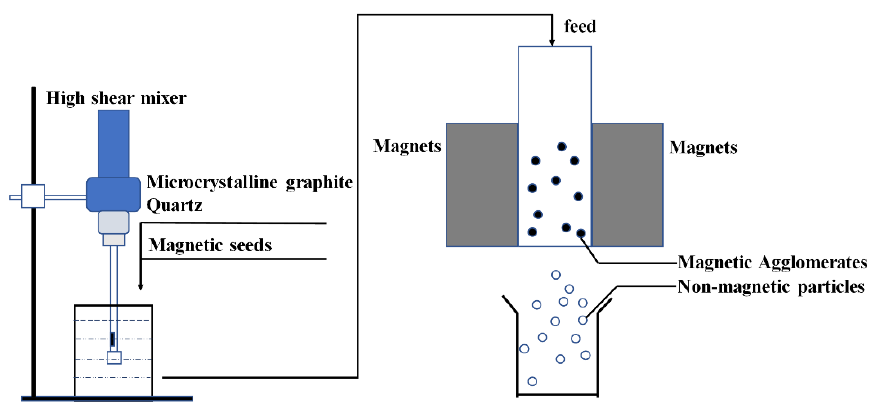
Figure 1. Experimental set-up for the magnetic seeding.